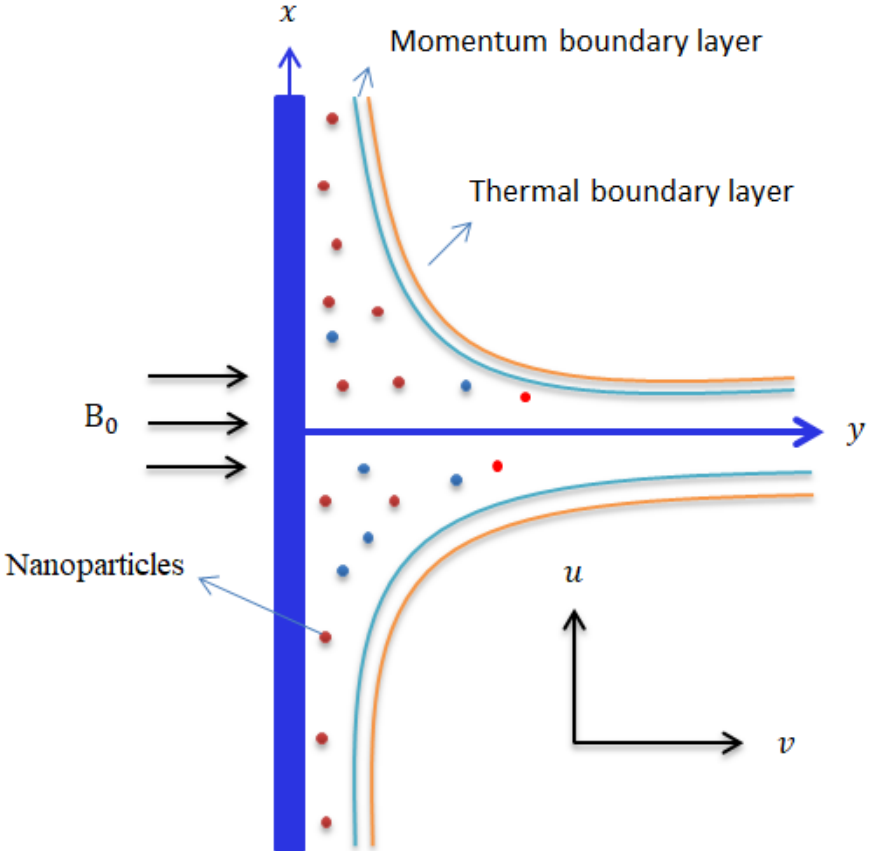
Figure 2. Illustration of the geometry of the current analysis.